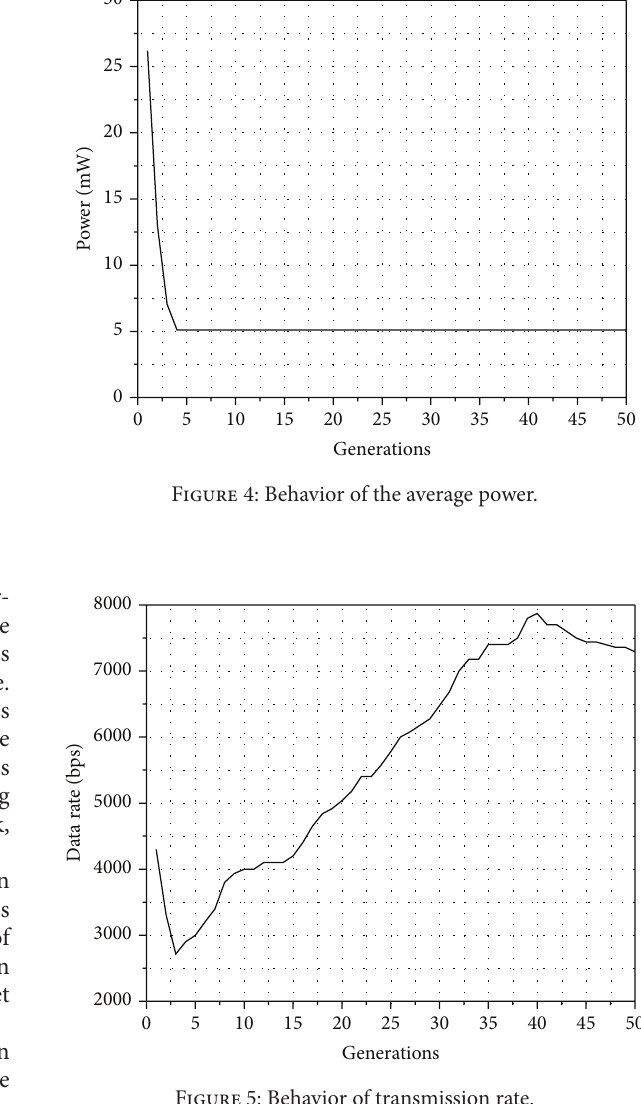
Figure 5: Behavior of transmission